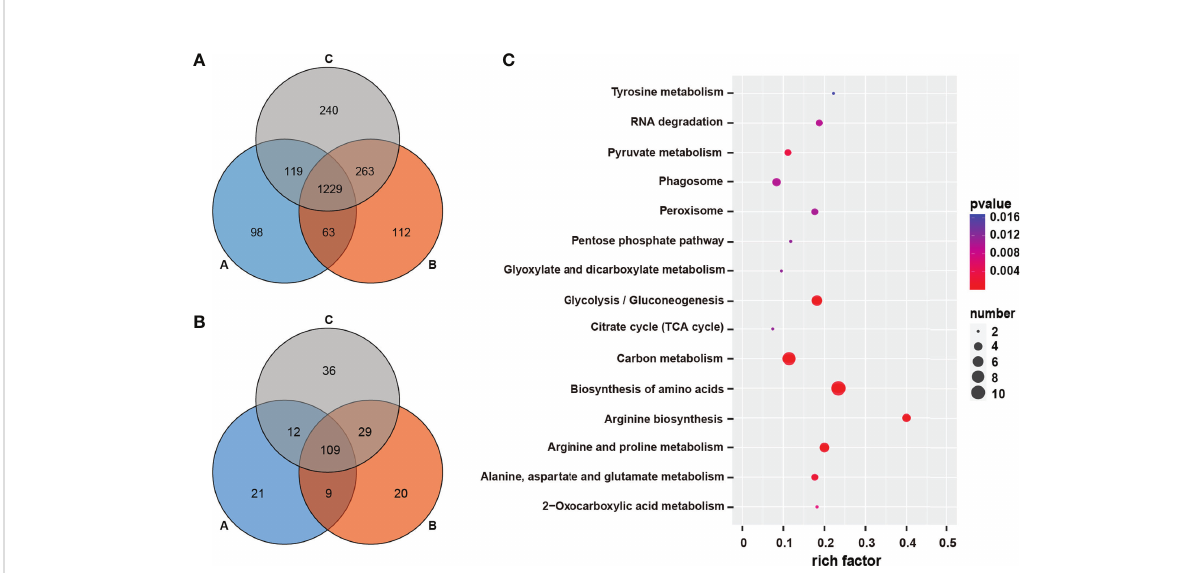
FIGURE 2 Wenn analysis of co-expressed genes in different groups and pathway enrichment of co-highly expressed genes. (A) Wenn analysis of co- expressed genes in three groups; (B) Wenn analysis of co-highly expressed genes in three groups; (C) Pathway enrichment of co-highly expressed genes in three